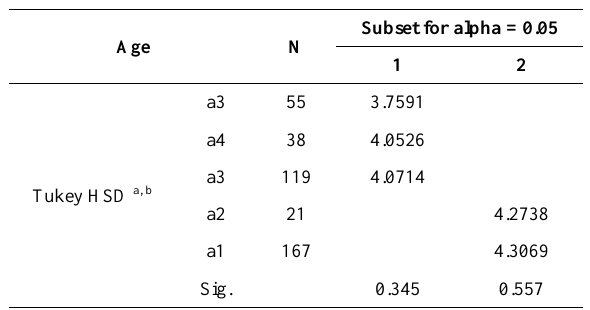
Table 14. Tukey test - Table of